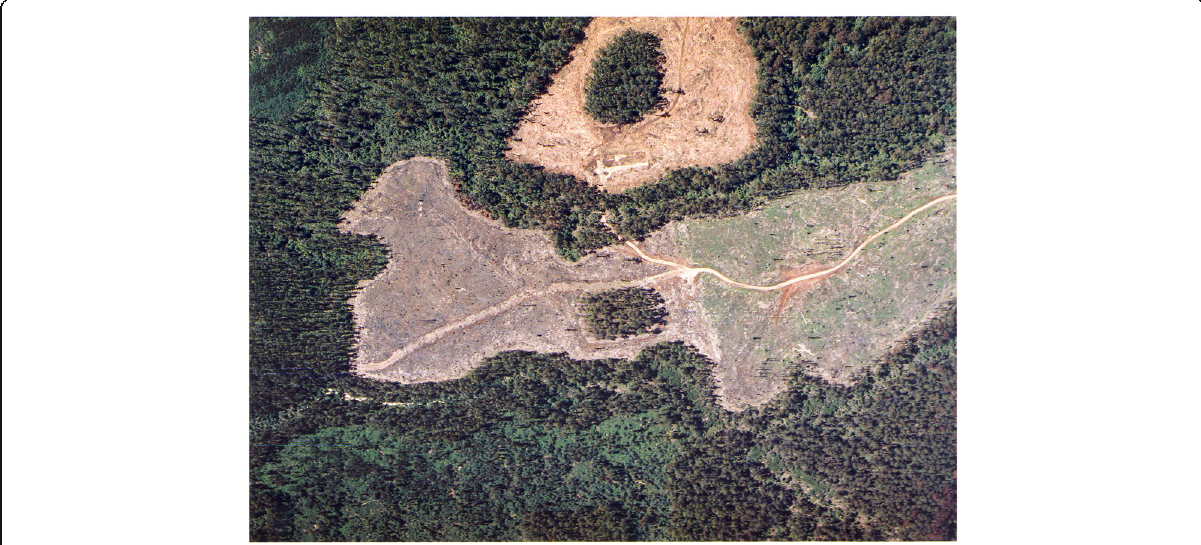
Fig. 2 Aerial view of retained islands in the variable retention harvesting experiment in the Mountain Ash forests of the Central Highlands of Victoria, south-eastern Australia. (Photo: W.